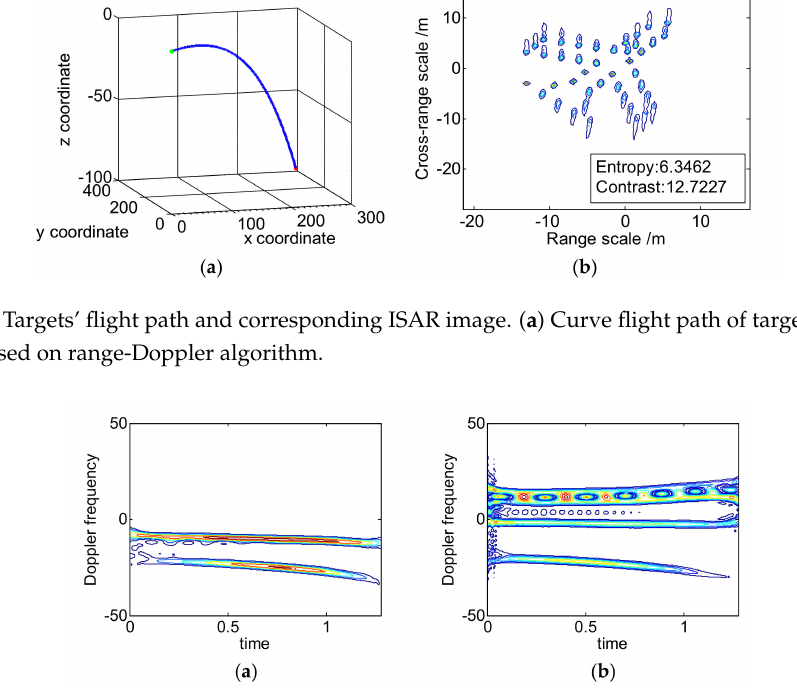
Figure 8. Time-frequency representation of cross-range signals in the cross-range direction. ( a ) Signal in range cell 485; ( b ) signal in range cell 508.